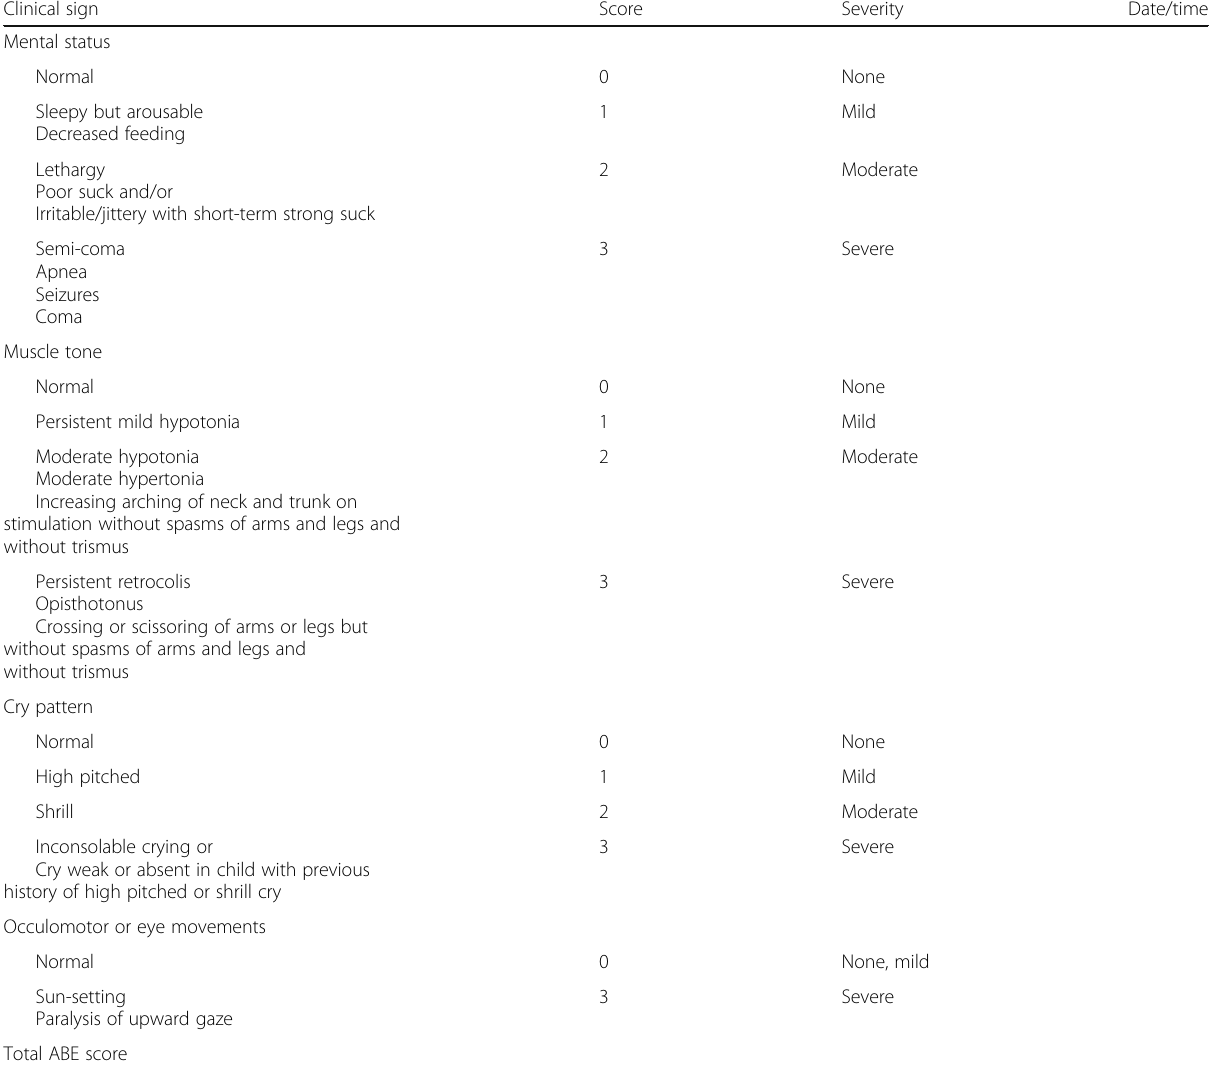
Table 1 Modified bilirubin-induced neurological dysfunction (BIND) score Clinical